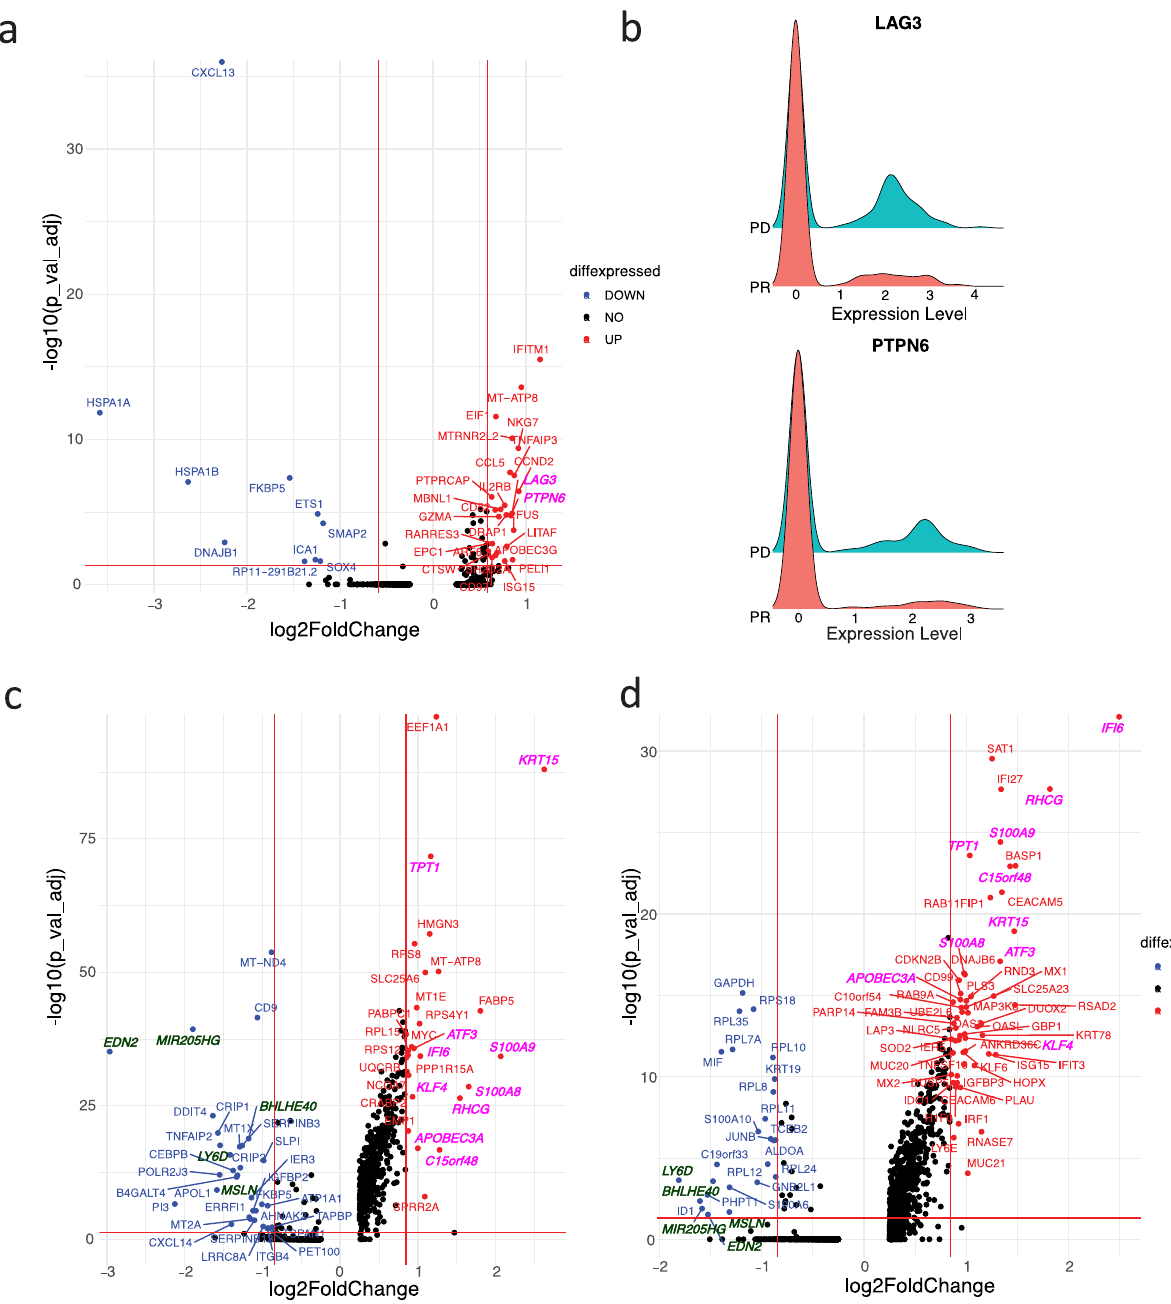
Fig. 3 Increased expression of T cell exhaustion markers LAG3 and PTPN6, APOBEC3A, and interferon-inducible protein IFI6 in the progressing laryngeal SCC. a Volcano plot of differentially expressed genes in dysfunctional CD8 + T cell (CD8_dys_CXCL13) in laryngeal SCC vs NPSCC and NPSCC lymph node shows increased expression of two T cell exhaustion markers LAG3 and PTPN6 (italicized pink font) in laryngeal SCC. Only genes with log2FoldChange larger than 0.25 were shown. Wilcoxon Rank Sum tests were performed and p values were adjusted by Bonferroni correction. Horizontal red line: − log10(0.05); vertical red lines: + / − log2(1.5). b Ridge plots of expression of LAG3 and PTPN6 in tumors with fold changes of 1.80, 1.79 and adjusted p values of 1.3e − 5, 1.8e − 5, respectively, comparing the laryngeal SCC (PD) to two regressing lesions (PR). c , d Volcano plots of differentially expressed genes in Epithelial_1(C) and Epithelial_2(D) in laryngeal SCC vs NPSCC and NPSCC lymph node. Commonly upregulated and down-regulated genes in laryngeal SCC were shown in italicized pink and dark green fonts, respectively, supporting increased APOBEC3A expression stimulated by interferon signaling. Horizontal red line: − log10(0.05); vertical red lines: + / −